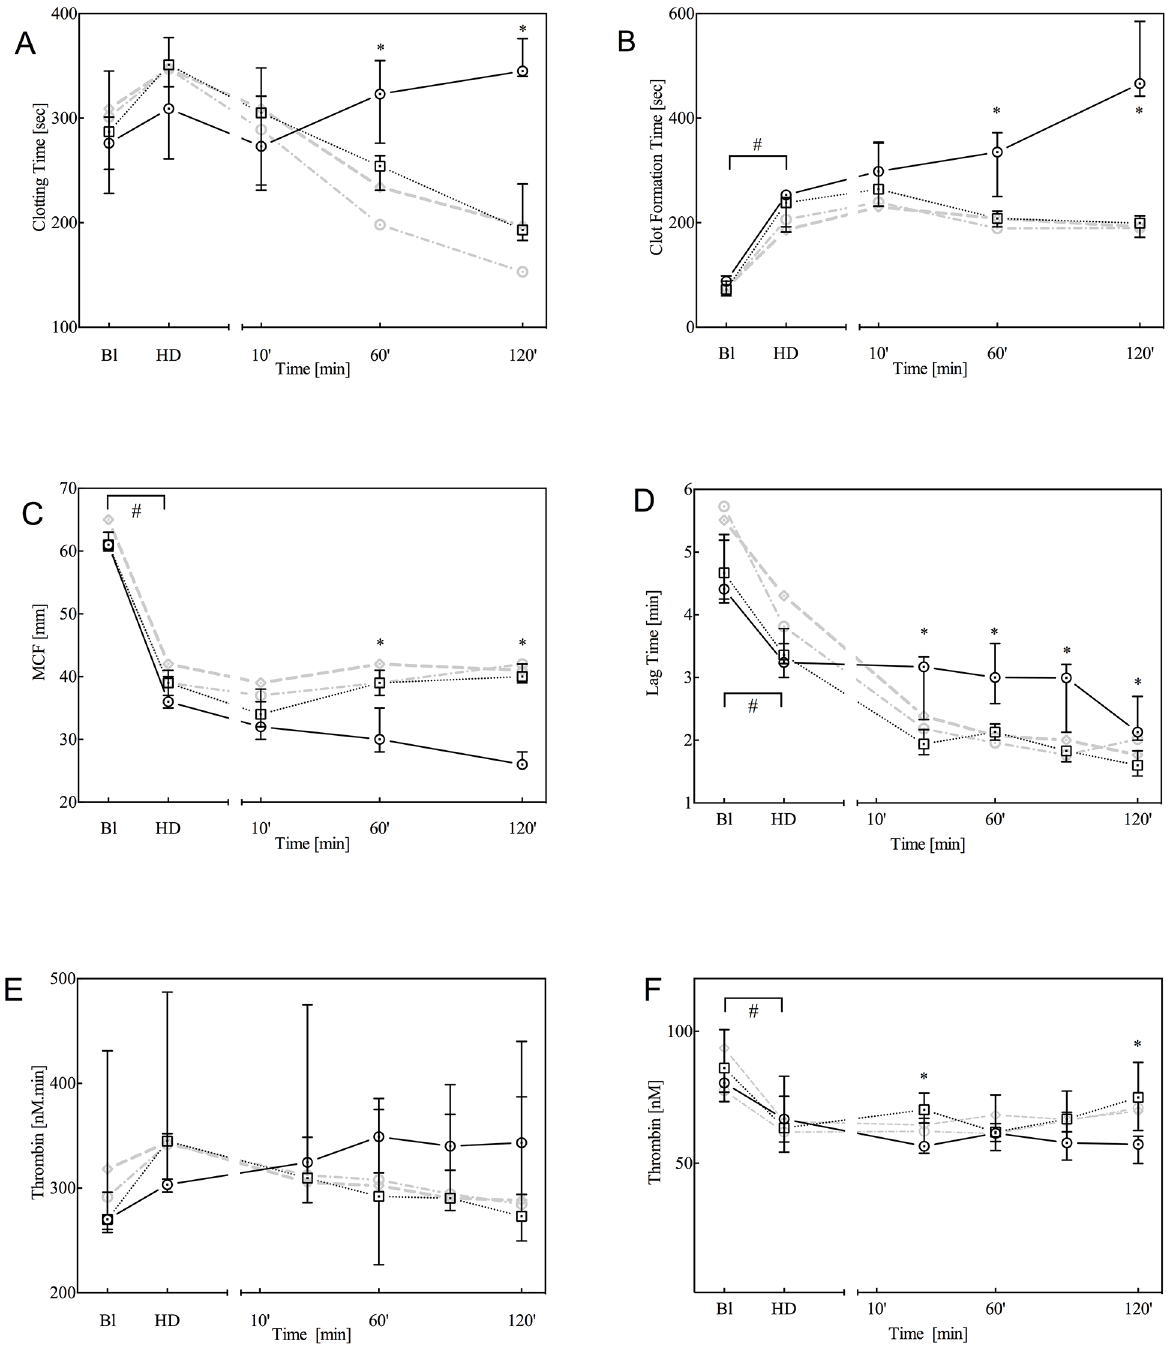
Fig 3. Thromboelastometry (TEM) analysis by means of ExTem (A, B and C) and plasma thrombin generation analysis (D, E, F; triggered by 0.25 pM TF) at baseline (Bl), after haemodilution (HD) and 10, 60 and 120 minutes after trauma. For TEM, the parameters clotting time (CT: A), clot formation time (CFT: B) and maximum clot firmness (MCF: C) are given, whereas for thrombin generation the lag time (D), endogenous thrombin potential (ETP; E) and peak height (F) are given. Data are presented as the median with inter-quartile ranges (IQR) for controls (solid black line, n = 7) and animals treated with 90 μ g/kg rFVIIa (dotted black line, n = 7). For comparison, data from animals treated with either 180 or 360 μ g/kg rFVIIa are presented as grey dotted lines. * P < 0.05 control versus rFVIIa; # P < 0.05 over time between baseline and haemodilution.